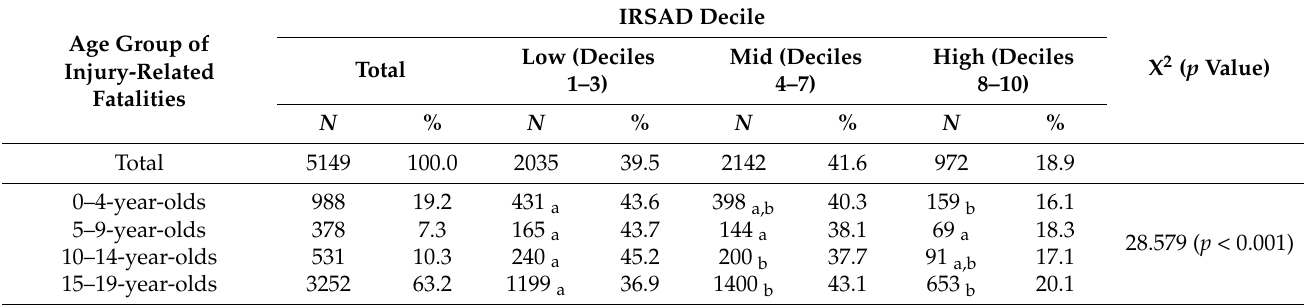
Table 7. Injury-related fatalities by age group and index of relative socio-economic advantage and disadvantage decile (IRSAD), Australia, 2007/08 to